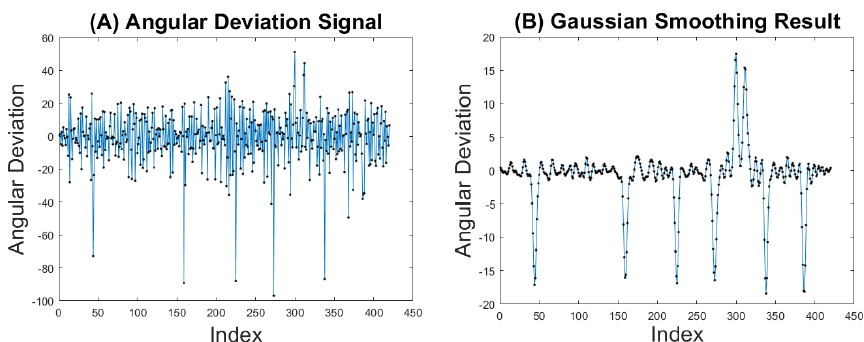
Figure 7. Gaussian Smoothing. ( A ) Angular Deviation Signal. ( B ) The denoised signal after applying Gaussian Smoothing.